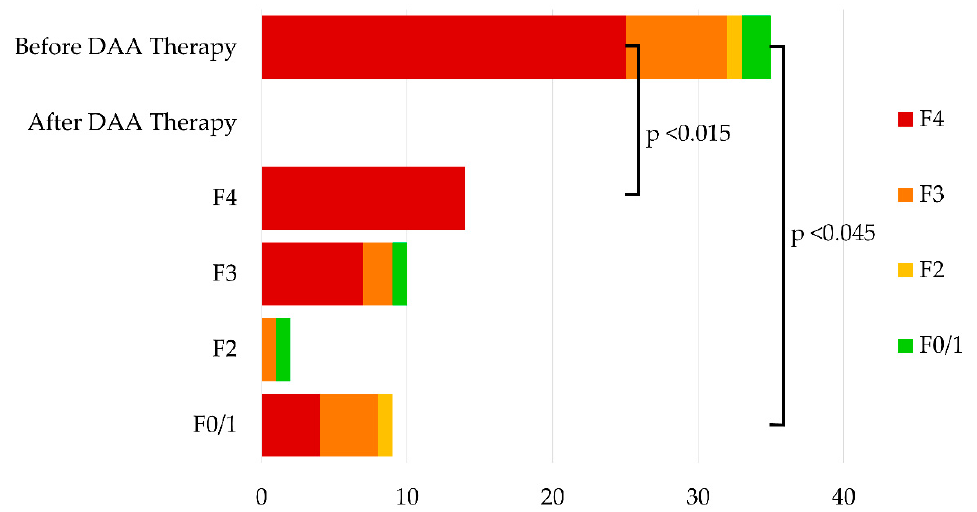
Figure 5. The bar plots demonstrate the improvement of liver fibrosis following antiviral treatment. The liver stiffness was determined during a pre-treatment ultrasound scan with shear wave elastography (SWE). Liver fibrosis was classified into four METAVIR stages (F0/1, F2, F3, F4) based on the SWE measurement. The post-treatment measurement was performed 48 weeks after the completion of antiviral treatment. The number of patients in the different METAVIR stages is represented by the colored bands of the bar plots. Based on the METAVIR score, the number of cirrhotic cases (F4) was significantly lover ( p < 0.015) at EOT48w, while the number of cases with F0/1 showed significant increasement ( p < 0.045) after treatment compared to the baseline.